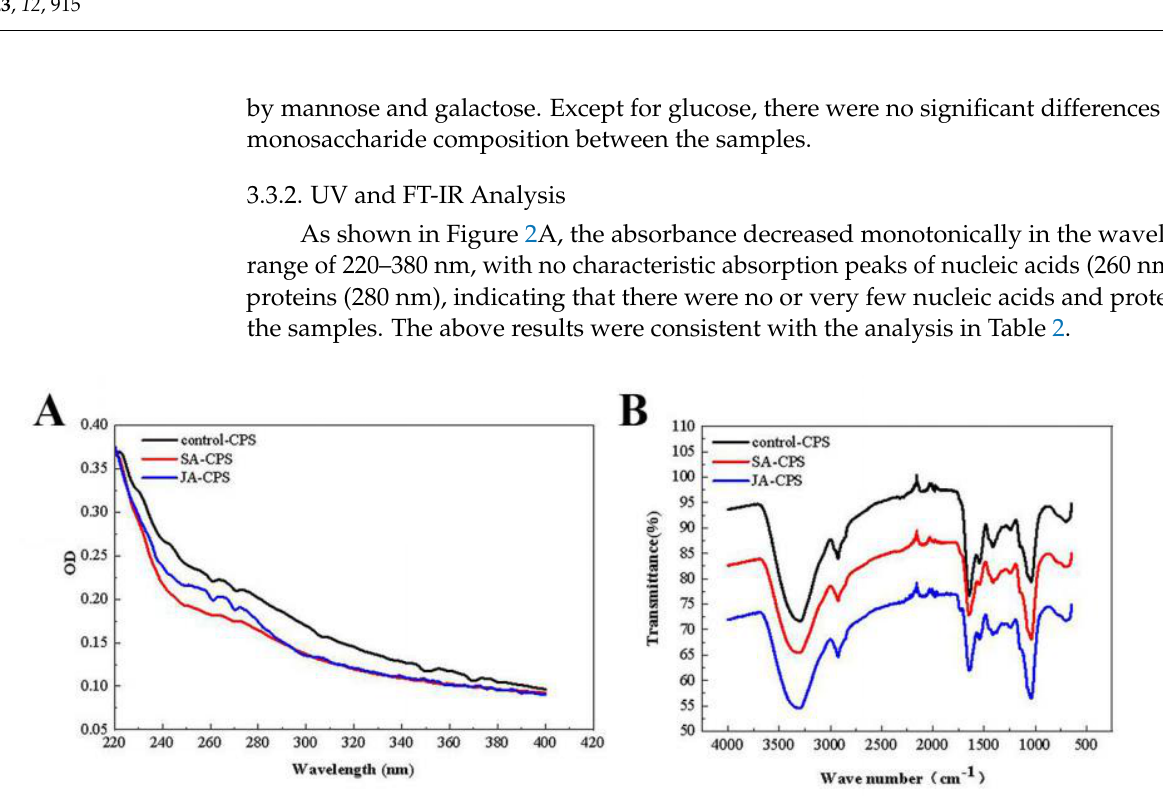
Figure 3. Antioxidant activities including the DPPH radical scavenging activity ( A ), the hydroxyl radical scavenging activity ( B ), and the ABTS + radical scavenging activity ( C ) of the control-CPS, SA-CPS, and JA-CPS. The hydroxyl radical (·OH) is a free radical with strong oxidation ability, which easily oxidizes various organic and inorganic substances. It has a high oxidation efficiency and